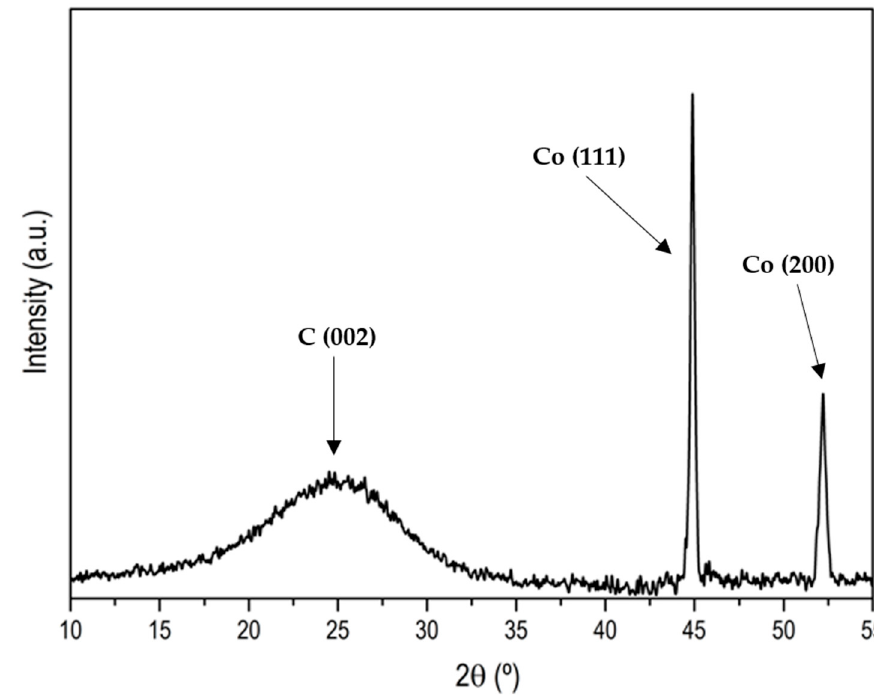
Figure A8. XRD pattern of ZIF67C_1000.